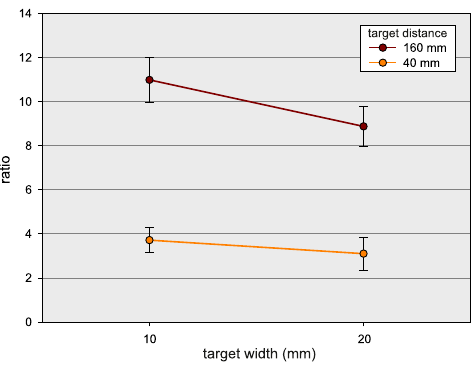
Figure 7. Analysis of the interaction between target distance ( 40 vs . 160 mm ) and target width ( 10 vs . 40 mm ). Trajectories were fitted to ellipses, and the ratios of the resulting radii were used as indices of